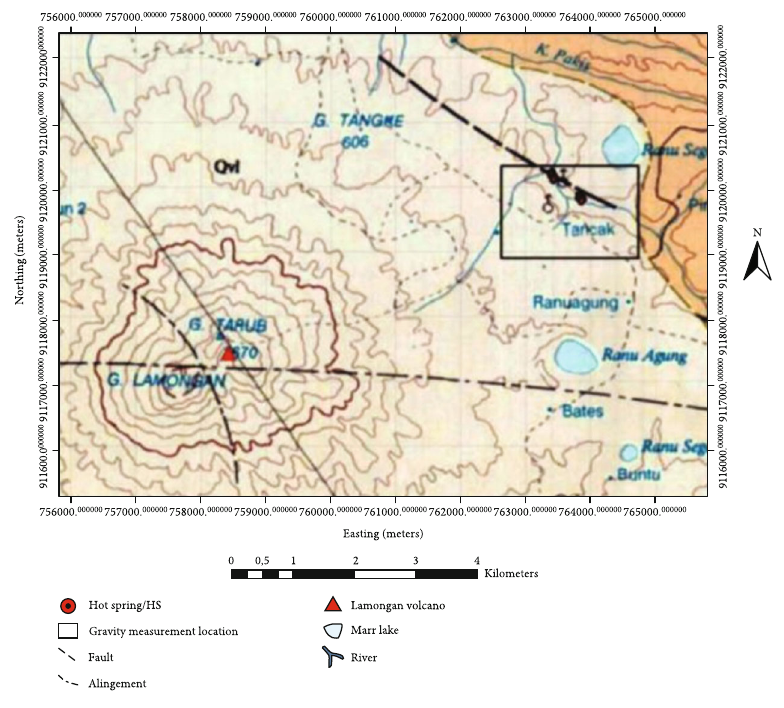
Figure 10: Geological map of research location sheet Probolinggo.